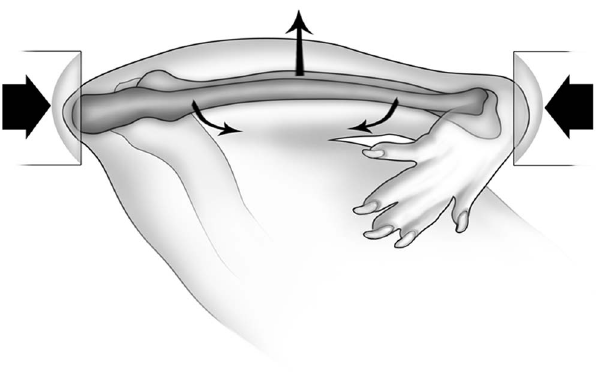
Fig. 1. Schematic diagram of the ulna loading model. The antebrachium was placed horizontally in loading cups attached to a materials testing machine. The medio-lateral diaphyseal curvature of the ulna is accentuated through axial compression, most of which is translated into a bending moment. Reproduced from [18] with permission from John Wiley & Sons.